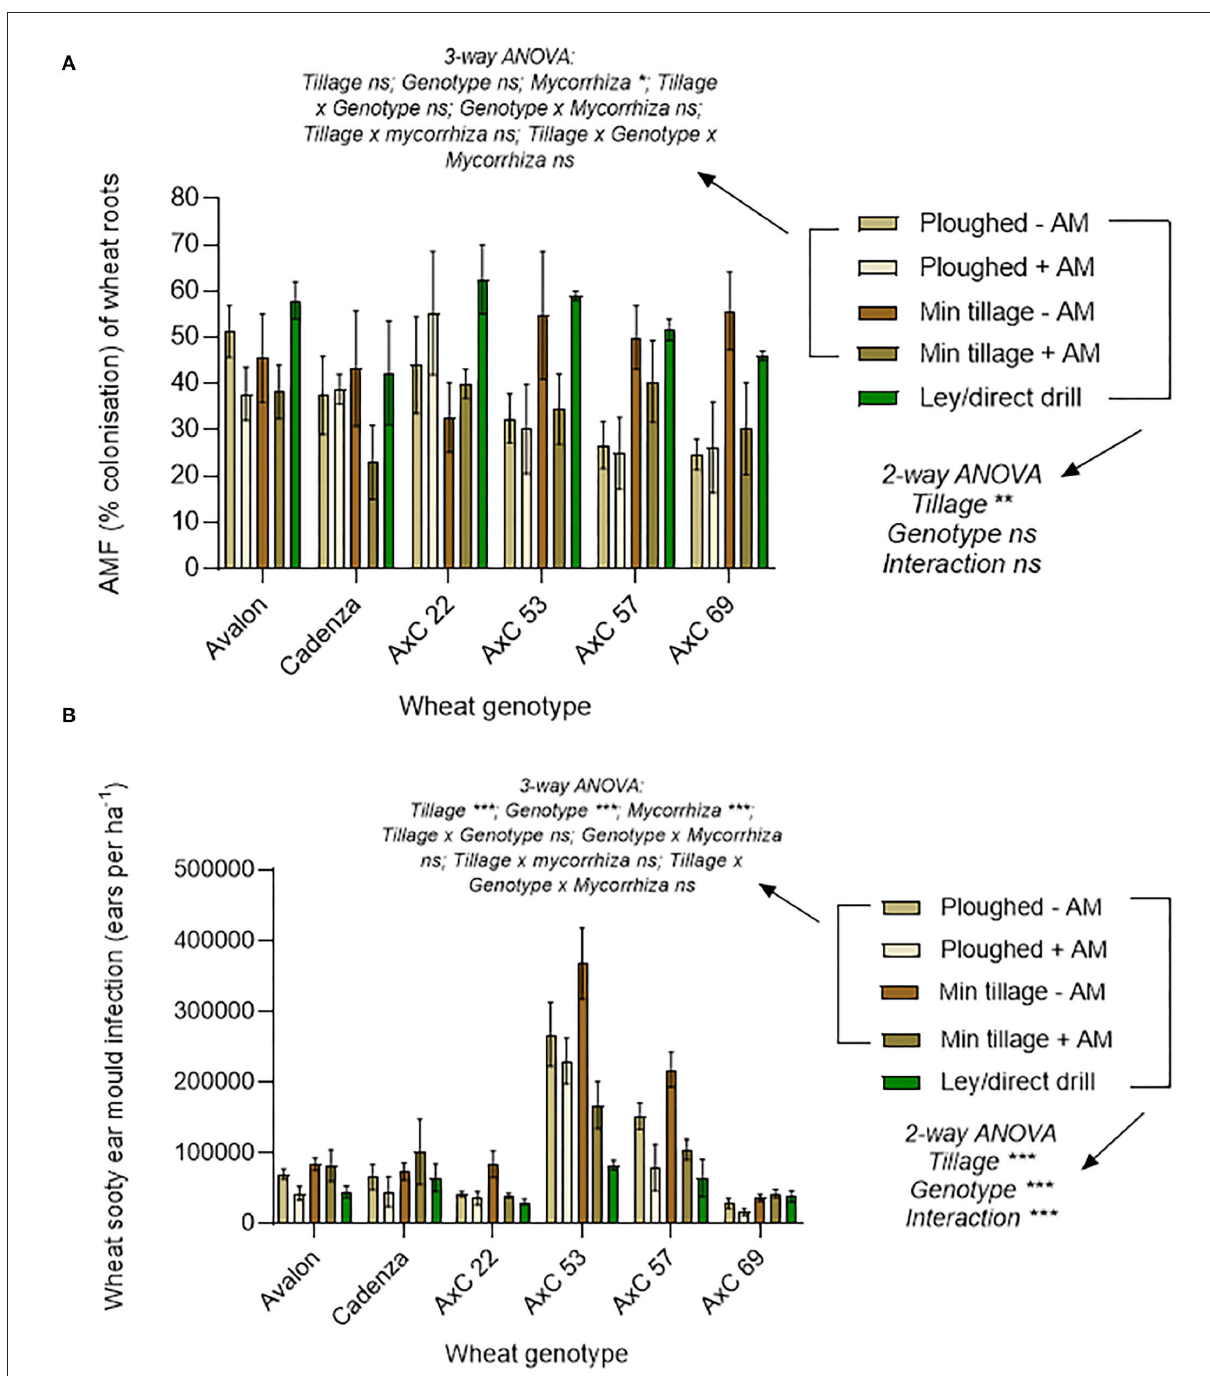
FIGURE9 Effects of wheat genotype (Avalon, Cadenza, AxC22, AxC53, AxC57, AxC69), tillage (plough, disc cultivated, and direct drill), mycorrhiza inoculum (- sterile carrier, + commercial mycorrhizal inoculum), and ley on (A) total mycorrhizal abundance (% colonisation of wheat roots by hyphae, arbuscules, and vesicles) ( n = 16–18 for each wheat line or parent), and (B) effects on the amount of sooty ear mould (ears ha − 1 ) ( n = 20 for each wheat line or parent). Error bars show ± 1 SE. The results of the three-way ANOVA testing for effects of genotype, mycorrhizal inoculum and tillage (ploughing vs. disc cultivated), and their interactions are presented for the permanent arable plots (excluding the ley). In parallel, the two-way ANOVA results are presented for effects of tillage (direct drilled ley, disc cultivated, and ploughed) and genotype, and their interaction, averaging across the mycorrhizal inoculum treatments, and including the ley plots. In each case, * p = 0.05; ** p = 0.001; and *** p < 0.0001